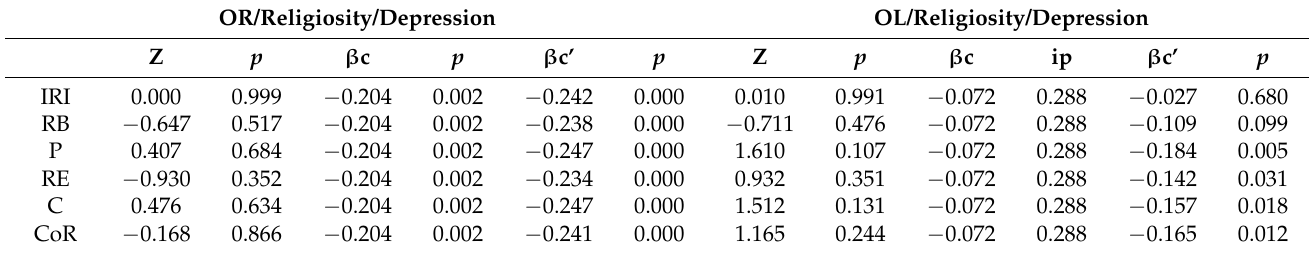
Table 4. Indirect effects of ego-resiliency on psychopathological reaction through religiosity.